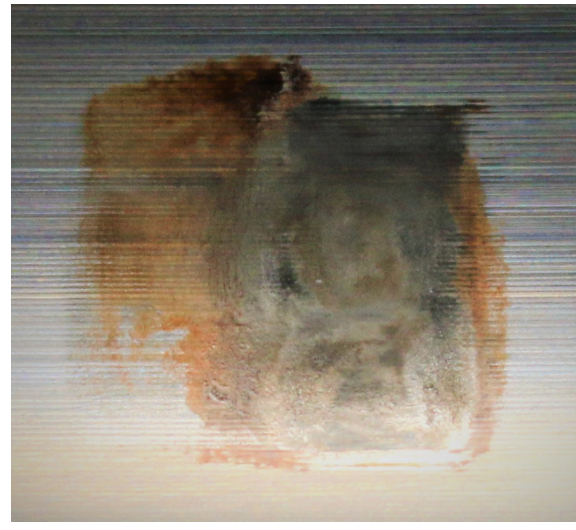
Figure 15. Wear mark from a test with a failed protection